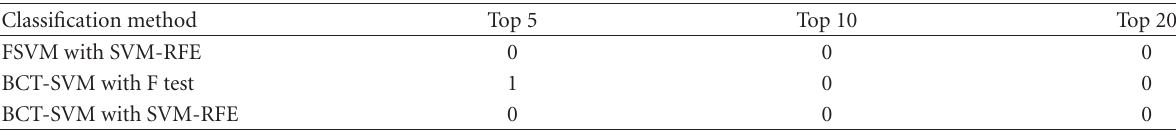
Table 6. Classifiers’ performance on small round blue-cell tumors dataset by cross-validation (number of wrong classified samples in leave-one-out test). Classification